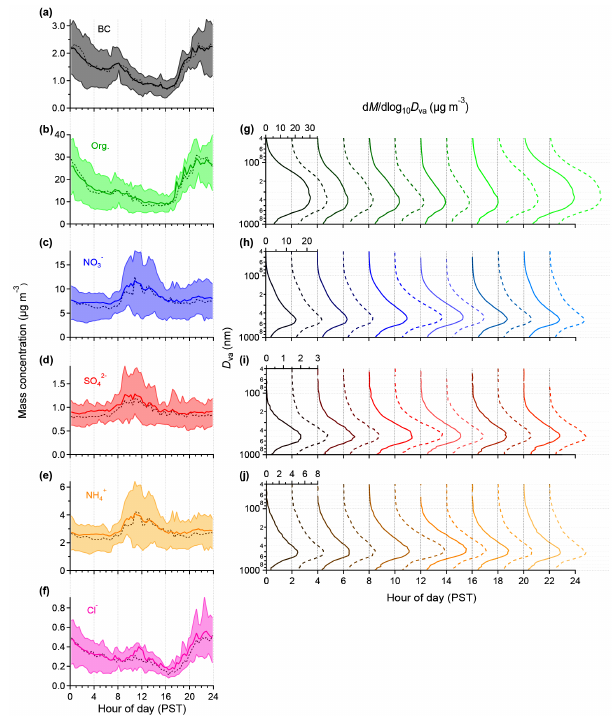
Figure 4. (a–f) Average diurnal profiles of each of the PM 1 species where BC measurements are from the SP2 (the 75th and 25th per- centiles are denoted by the top and bottom of the shaded region, the median values are denoted by the broken, dark colored lines, and the mean values are denoted by the solid, light-colored lines); (g–j) 2h average diurnal size distributions for each of the NR-PM 1 species. The size distribution of chloride is not included here due to its low signal-to-noise ratio. The vertical grid lines indicate the zero line for each of the 2h averaged mass-based size distributions and the start- ing hour of the averaging period (e.g., the zero line for the average size distribution for 06:00–08:00PST is the vertical line at the 6h tick). Each size distribution is scaled to the maximum mass range for that species, as indicated by the top axis for the 00:00–02:00PST distribution. The organic aerosol distribution has been smoothed us- ing the binomial smoothing algorithm within Igor. Mass-based diur- nal size distributions between 30 and 1400nm, of NR-PM 1 species, Org44, used to represent secondary organic aerosols, and Org41, used to represent hydrocarbon-containing aerosols, are shown in Fig.